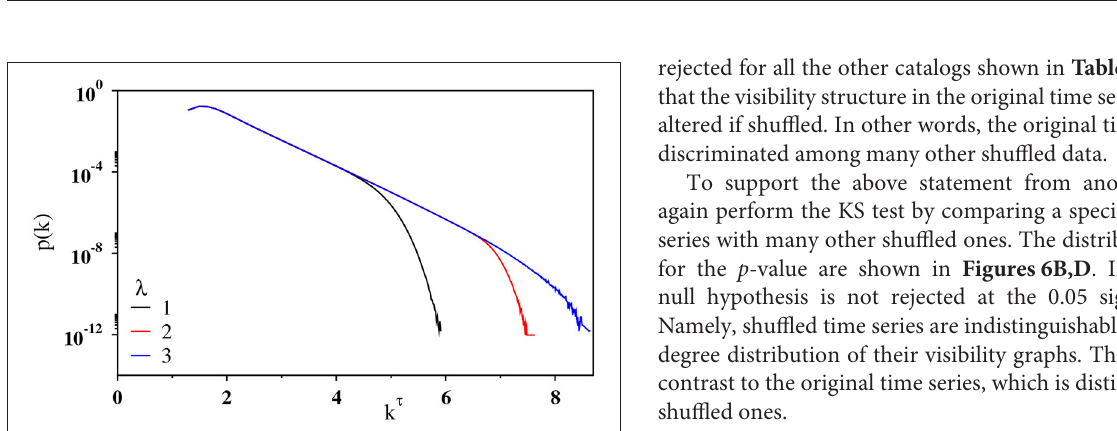
0.36 for the = 2 20 exponentially =